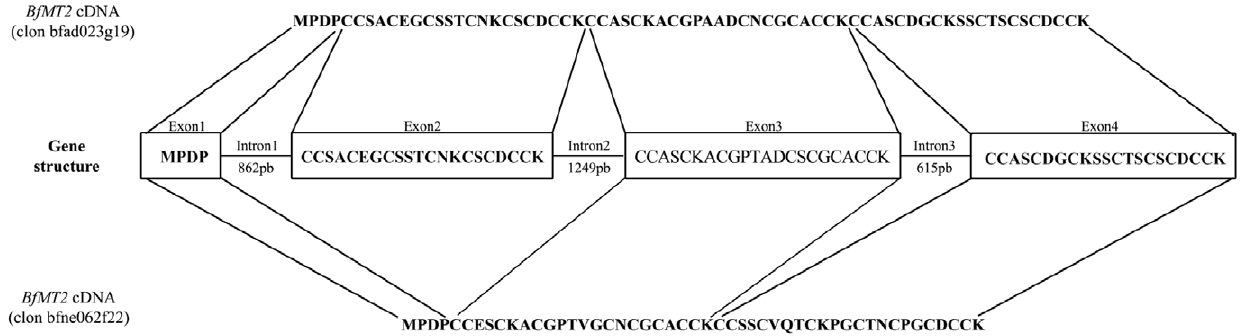
Figure 4. BfMT2 transcription proceeds through alternative splicing patterns. Schematic representation of the BfMT2 gene structure and the protein sequence corresponding to each exon (in the centre), and the protein sequences for each alternative cDNA. BfMT2 coding sequence used for translation was extracted from the NCBI Databank and corresponds to B. floridae strain S238N-H82. cDNA clone sequences were extracted and obtained from the B. floridae cDNA